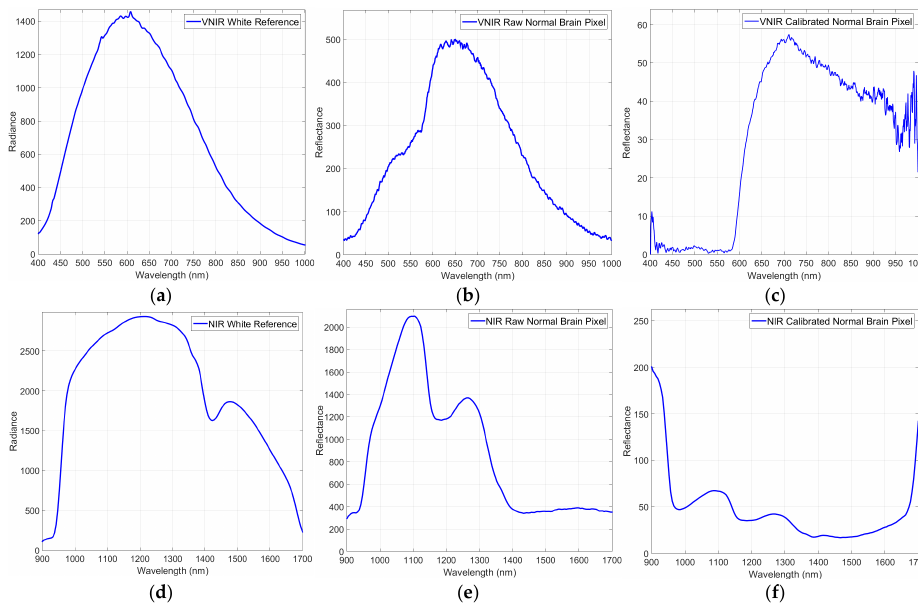
Figure 3. Calibration process of a certain pixel of the VNIR and NIR cameras. ( a ) The VNIR white reference spectrum; ( b , c ) The VNIR raw and calibrated spectra of a pixel of normal brain tissue; ( d ) The NIR white reference spectrum; ( e , f ) The NIR raw and calibrated spectra of a pixel of normal brain tissue.